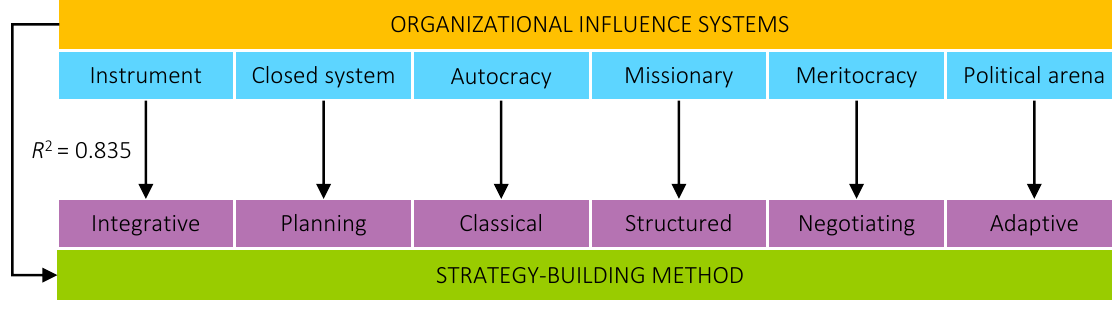
Figure 1. Influence of organizational power systems on strategy building